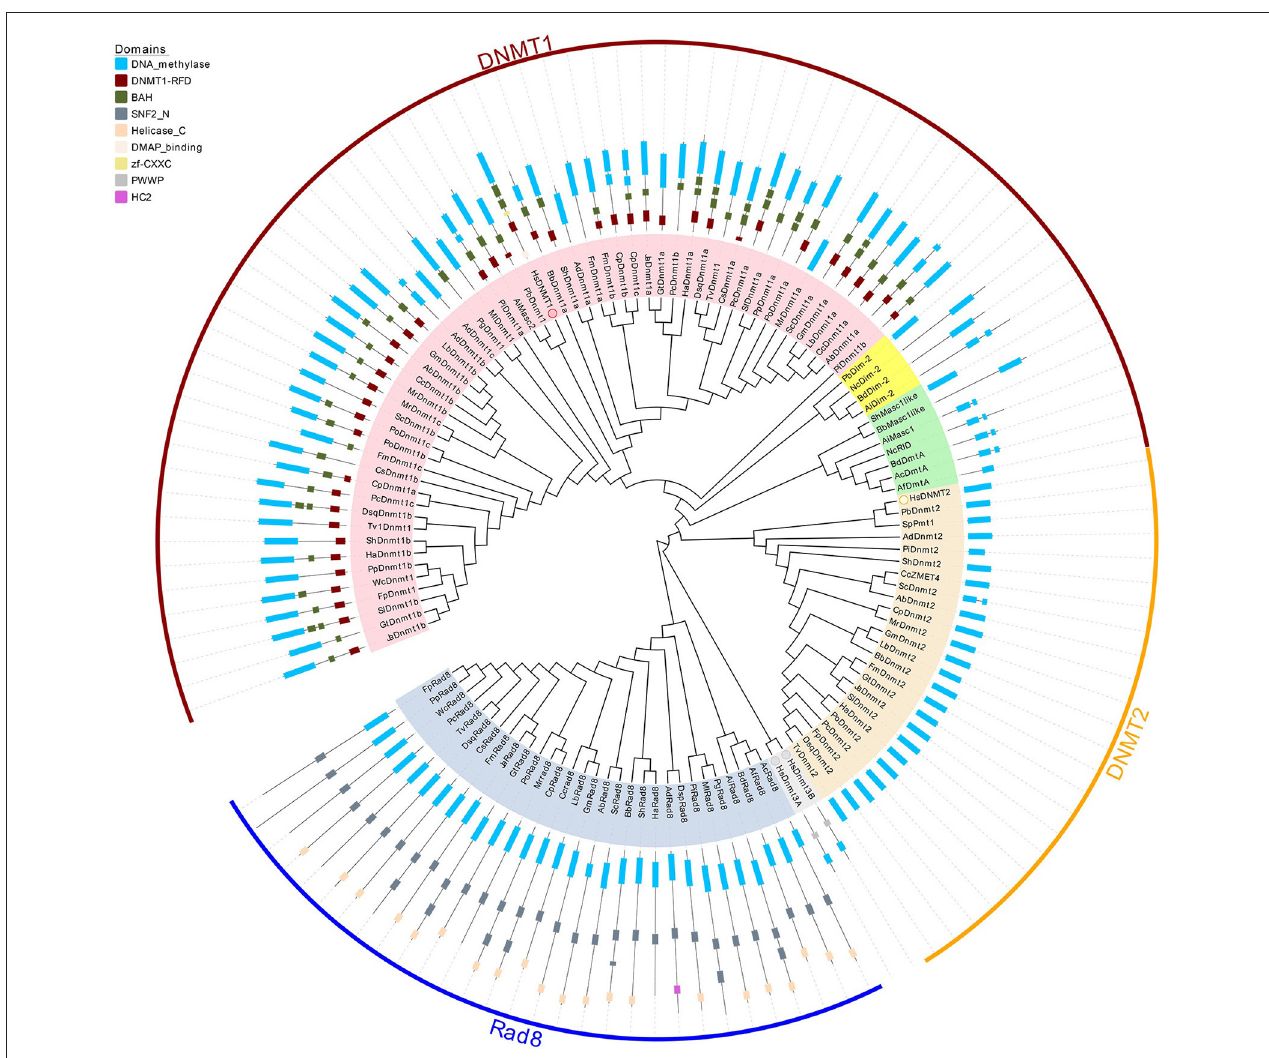
FIGURE 2 | Phylogenetic and domain architecture analysis of DNA methylase domain containing proteins in fungi. The ML tree was constructed with the conserved catalytic domains of the predicted 123 proteins from 39 species (listed in Supplementary Table 1) using the MUSCLE v3.8.31 and MEGA6.0 with 1000 bootstrapping replicates. The three families (Dnmt1, Dnmt2, and Rad8) and 3 subfamilies (Dnmt1/Masc2, Dim-2, Masc1/RID) are marked in different colors. The domain architecture analysis of the identified proteins was performed by the Pfam